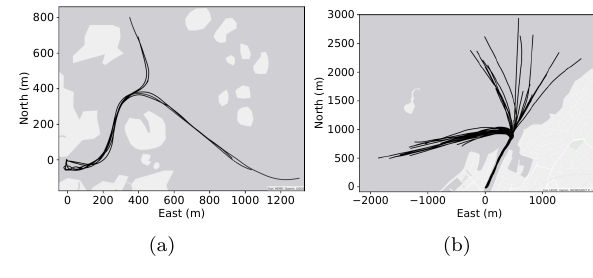
Figure 2: Northeast path taken by the RV Gunnerus for all docking operations: (a) Mausund, and (b)